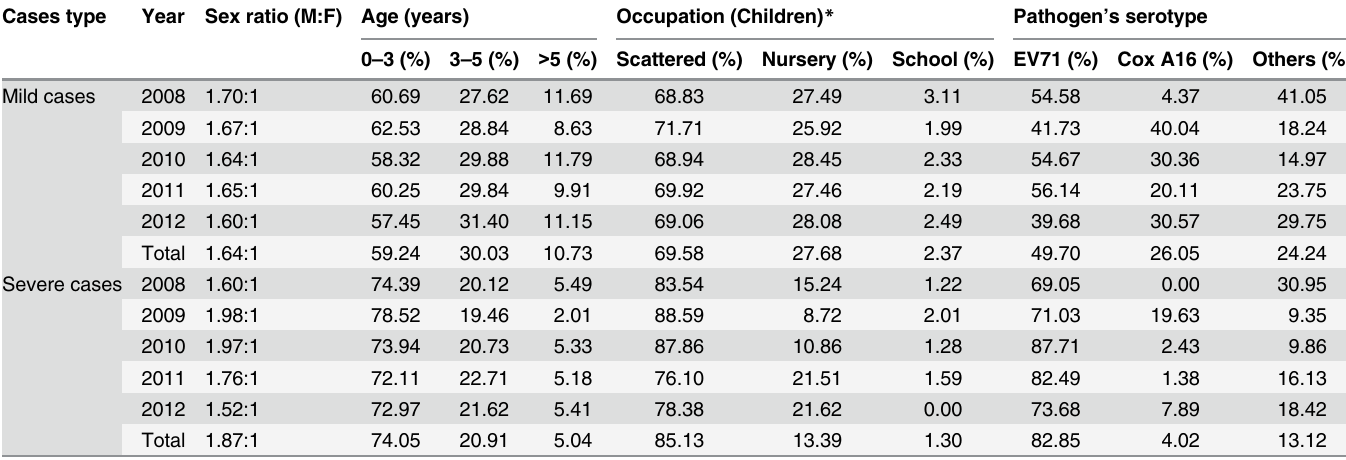
Table 1. Epidemiological characteristics of HFMD cases from Zhejiang Province, 2008 – 2012. Cases